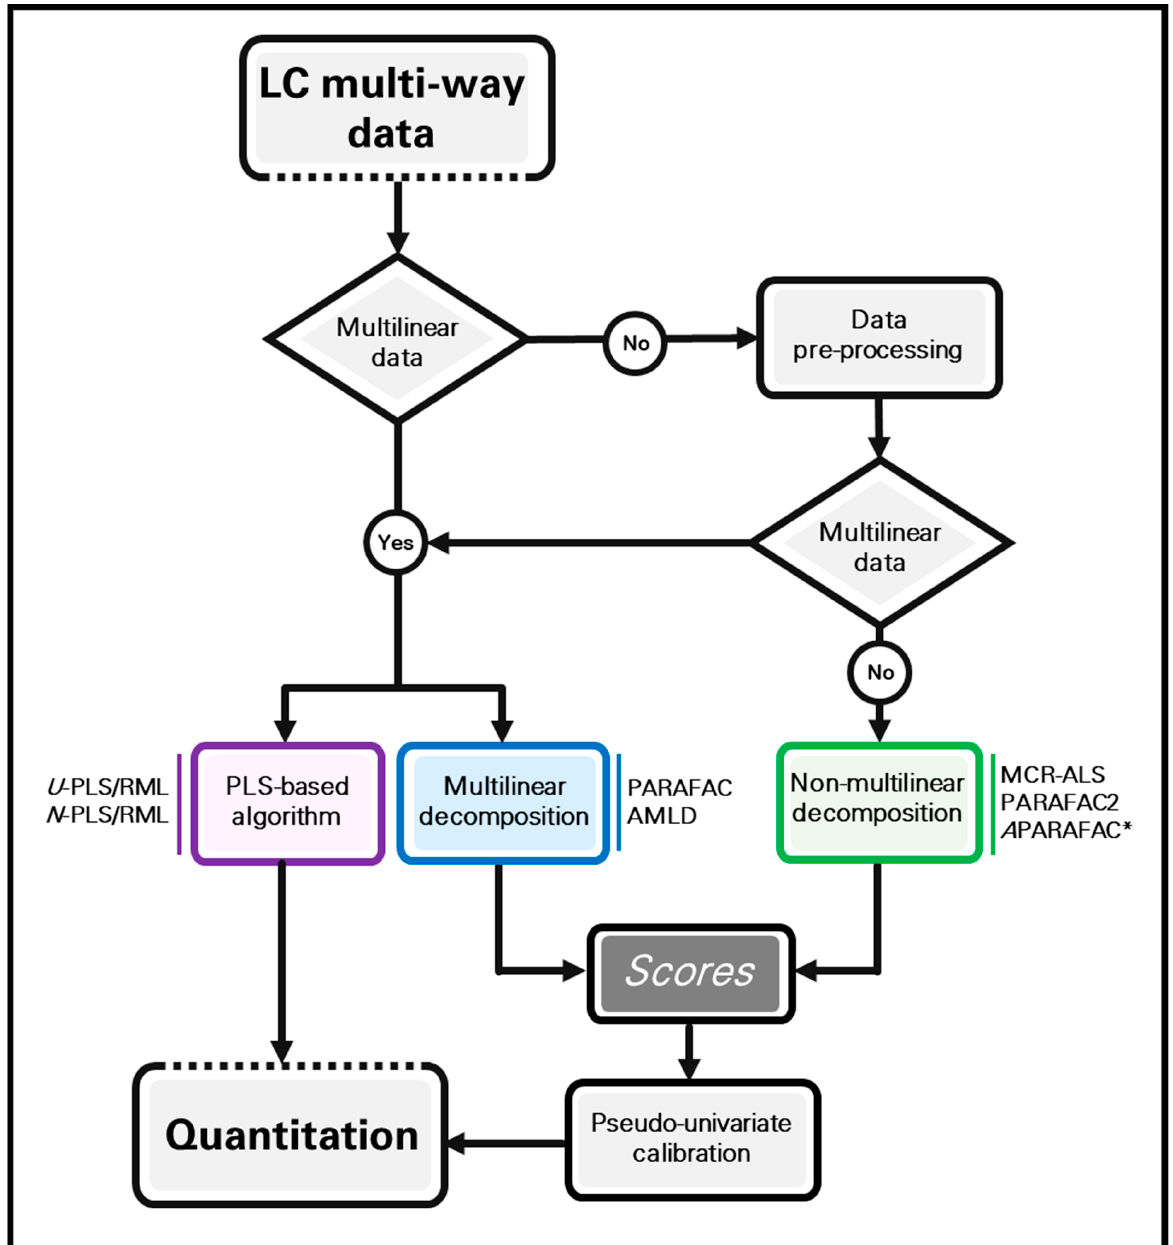
Figure 3. Flow ‐ chart showing different modelling approaches to analyse LC multi ‐ way data with quantitative aims. All Figure 3. Flow-chart showing different modelling approaches to analyse LC multi-way data with quantitative aims. All the the models are indicated as examples. A PARAFAC* is implemented only for third ‐ order data analysis. models are indicated as examples. A PARAFAC* is implemented only for third-order data